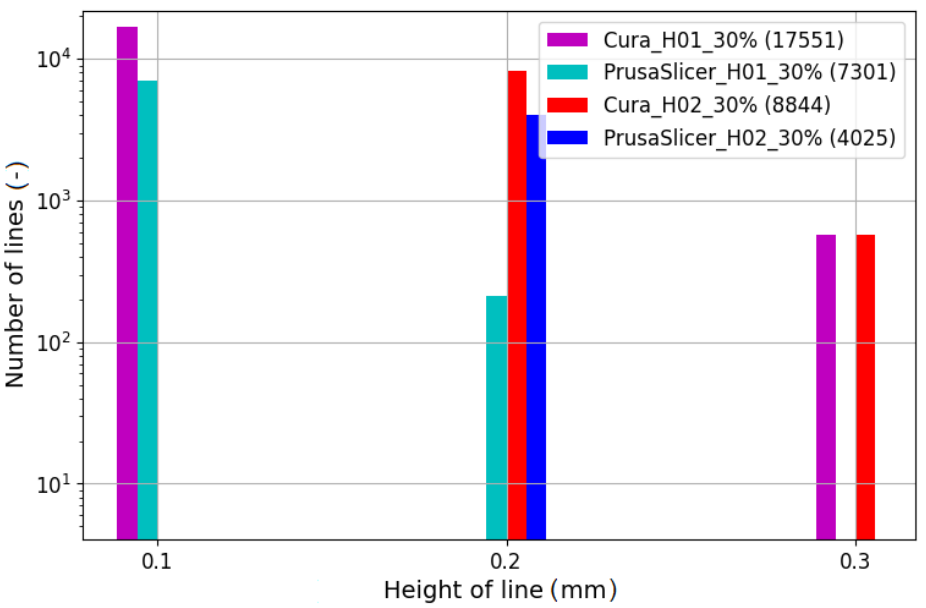
Figure 2. Number of lines considering their heights with the three allowed discrete values.